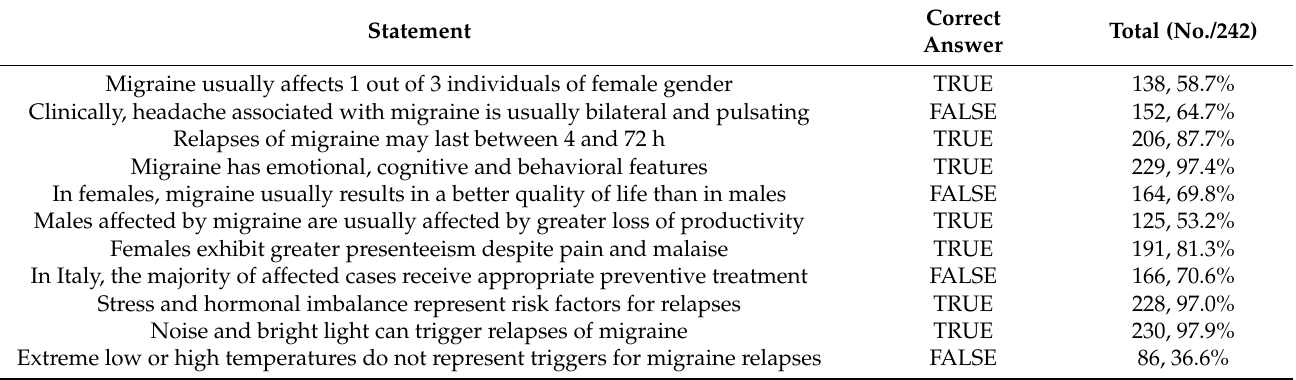
Table 2. Knowledge test: response distribution of presented items proposed to the 242 medical professionals participating in the survey and contributing to the assessment of general knowledge score (GKS) (Cronbach’s alpha =